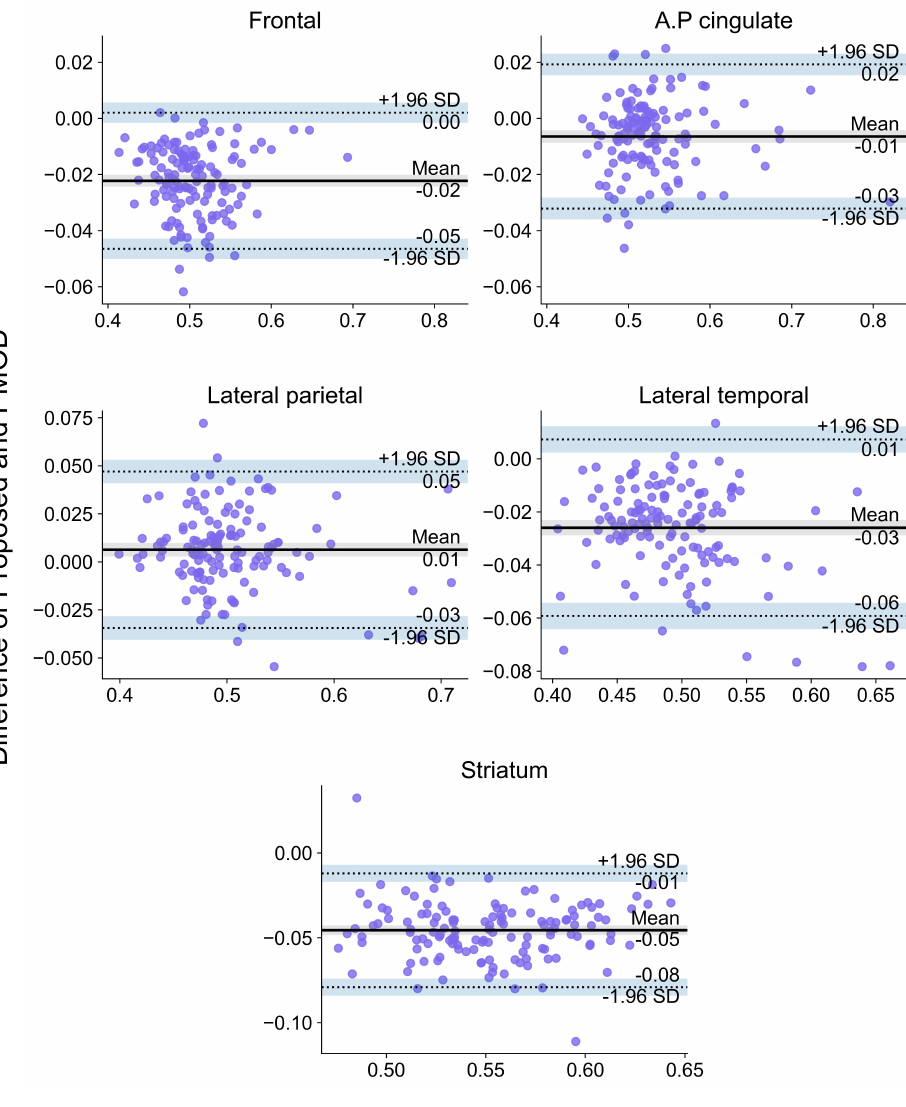
Figure A3. Bland–Altman plot in amyloidosis-negative subject for the comparison of our proposed method and PMOD. A.P. cigulate denotes anterior posterior cingulate